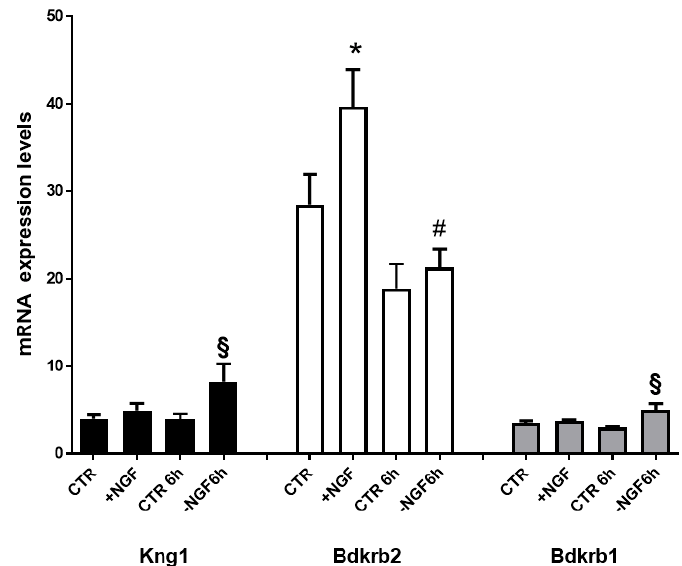
Figure 1. mRNA expression profiles of BK and its receptors genes after NGF treatment, deprivation, and rescue. Transcript levels of genes encoding BK ( Kng1 ; NM_012696), Bradykinin receptor 2 ( Bdkrb2 ; NM_001270713), and Bradykinin receptor 1 ( Bdkrb1 ; NM_030851) in cortical neurons (CNs) following 48 h NGF treatment ( + NGF), induction of apoptosis by 6 h NGF deprivation ( − NGF 6 h), and rescue by 6 h NGF replacement ( + NGF 6 h). Data represent means ( ± S.E.M.) from four replicates. Statistically significant di ff erences were calculated by one-way analysis of variance (ANOVA) followed by Bonferroni’s test for multiple comparison (* p < 0.001 vs CTR; § p < 0.05 vs CTR 6 h; # p < 0.05 vs. + NGF replacement ( + NGF).